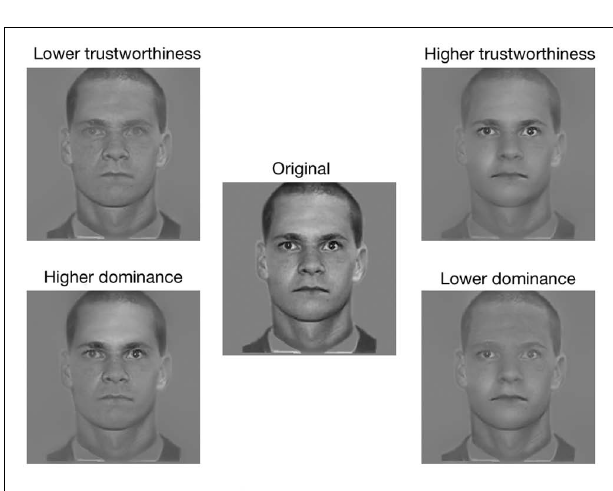
FIGURE 6 | Examples of the stimuli used in Experiment 2. Both pro- and anti- version of each social judgment as well as the original stimulus for the natural dataset are